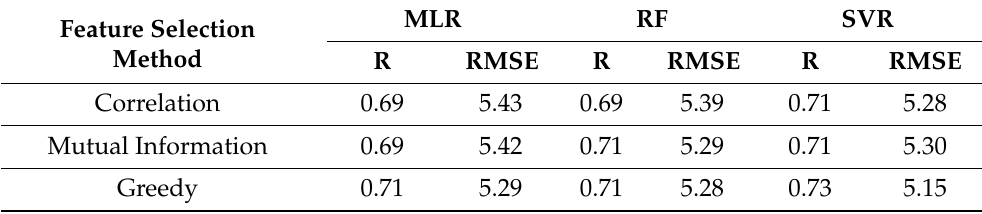
Table 7. Performance Metrics of Models for Recovery